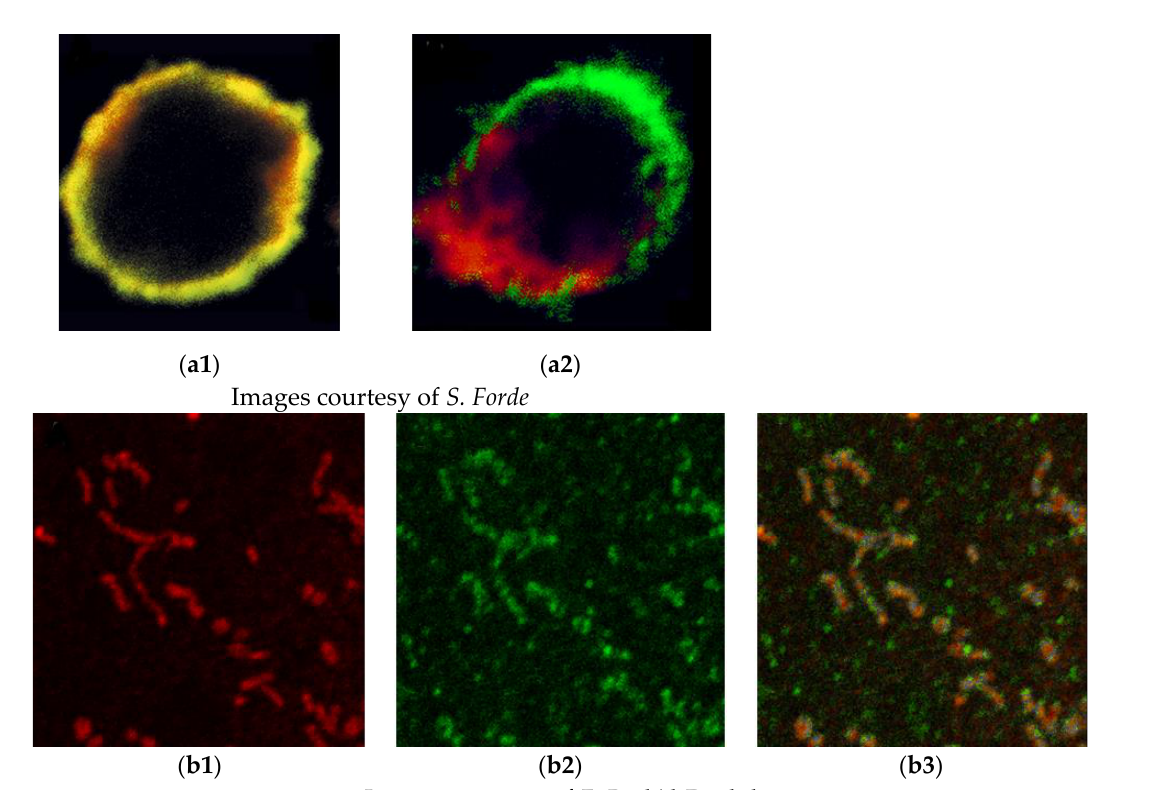
Figure 1. The interpretation of colocalization images. ( a ): Superimposition of immunofluorescence signal does not imply interaction. Stimulation of a stem cell reveals the independent segregation of membrane antigens. ( a1 ): Unstimulated stem cell showing strong overlap of red and green signals, which may imply association of antigens. ( a2 ): Following stimulation, antigens migrate to opposite poles of the cell, demonstrating they are not associated. ( b ): High-resolution imaging may not produce an overlapped yellow signal even though they are present on the same subcellular organelle. ( b1 ): Mitochondria stained with an organelle-specific marker. ( b2 ): A new putative candidate antigen for mitochondrial localisation. ( b3 ): Combined image showing little yellow signal as the mitochondrial marker is spatially separate from the green-labelled mitochondrial antigen.